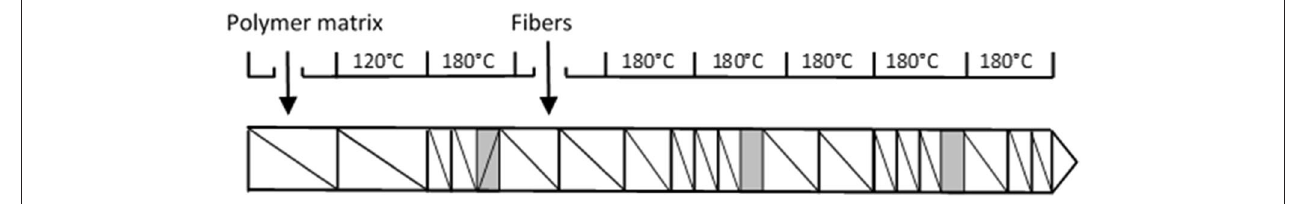
FIGURE 1 | Screw profile. The restrictive elements are in gray.